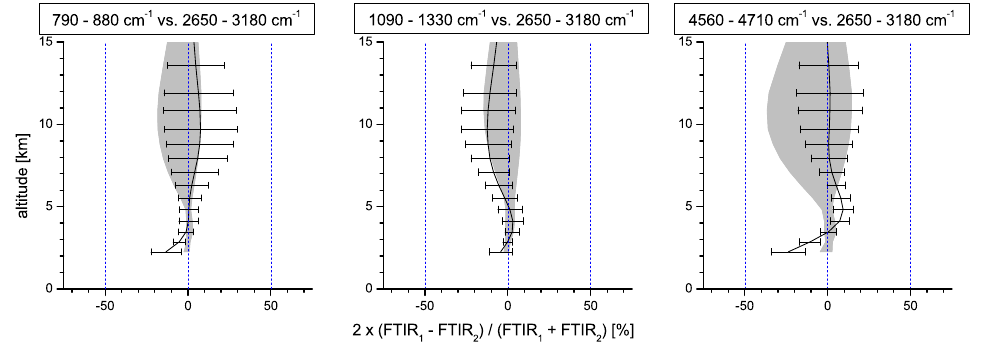
mixing ratios (in ppm) for the lower, middle, and upper troposphere ( 3 , 5 . 5 , 10 km, respectively). The blue solid line indicates the diagonal and the red dotted line the linear regression line. The correlation coefficient ρ and the slope of the linear regression line m are written in each panel.